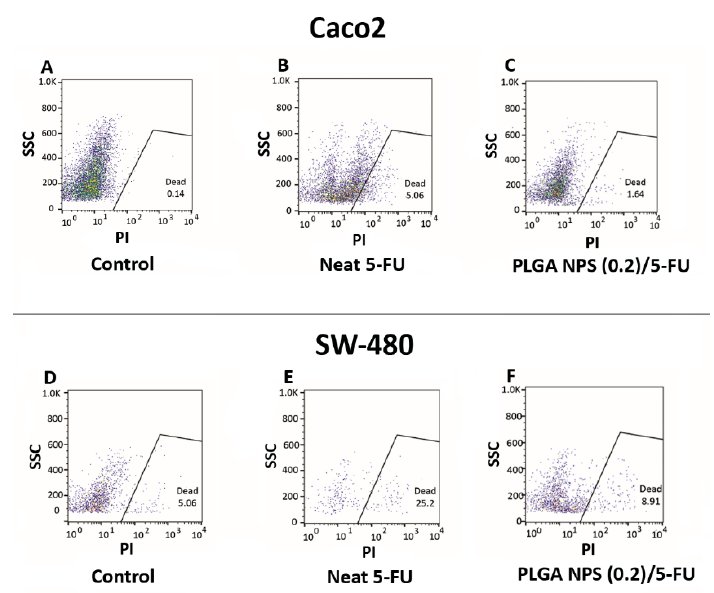
Figure 6. MTT cytotoxicity assay results: Caco2 ( A ) 24 h, ( B ) 48 h and SW-480 ( C ) 24 h and ( D ) 48 h. Also, IC50 of 5-FU dosage in various concentrations through cell culture ( E ). [One star stands for p- value less than 0.05 and two stars stand for p-value more than 0.1].